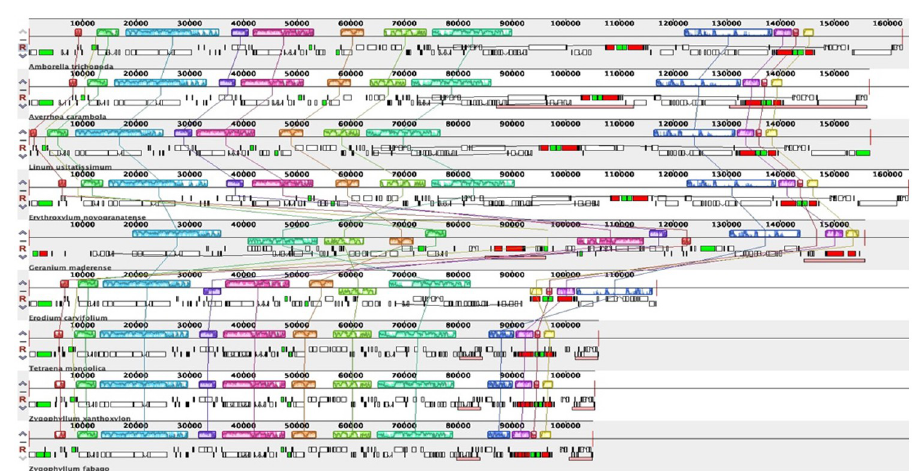
Fig 7. Gene order comparison of nine chloroplast genomes ( A . carambola , L . usitatissimum , E . novogranatense , G . maderense , E . carvifolium , T . mongolica , Z . xanthoxylon and Z . fabago ). A . trichopoda chloroplast genome as reference, utilizing MAUVE software. The boxes above the line indicate the gene sequences in clockwise direction and the boxes below the line indicate gene sequences in counterclockwise